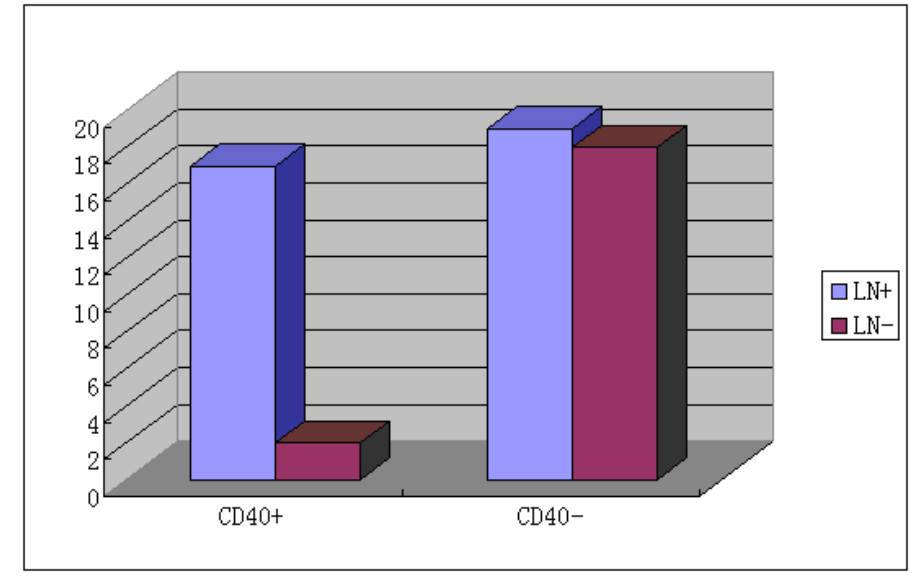
Figure 2. Correlation of CD40 expression with lymphatic metastasis.